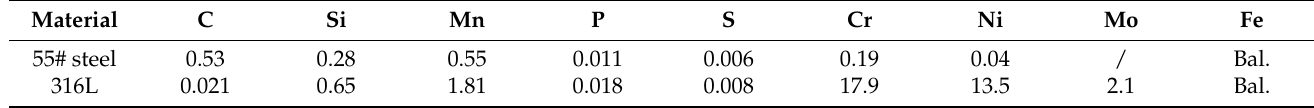
Table 1. Chemical composition of the 55# steel and 316L stainless steel (wt.%).